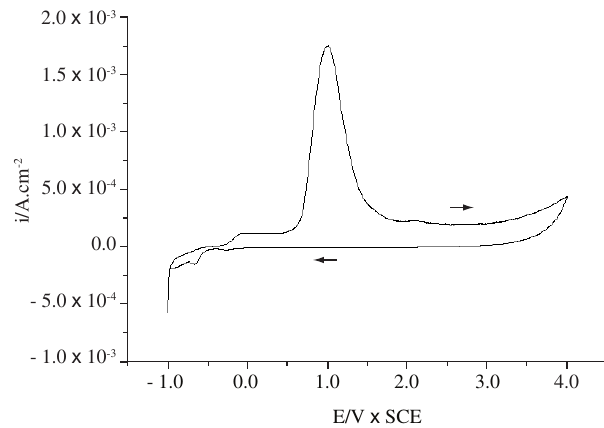
Figure 7. Bode plots of Ti6Al4V obtained at E citric acid ( ● ) containing bromide ( ■ ) and iodide ( ▲ )